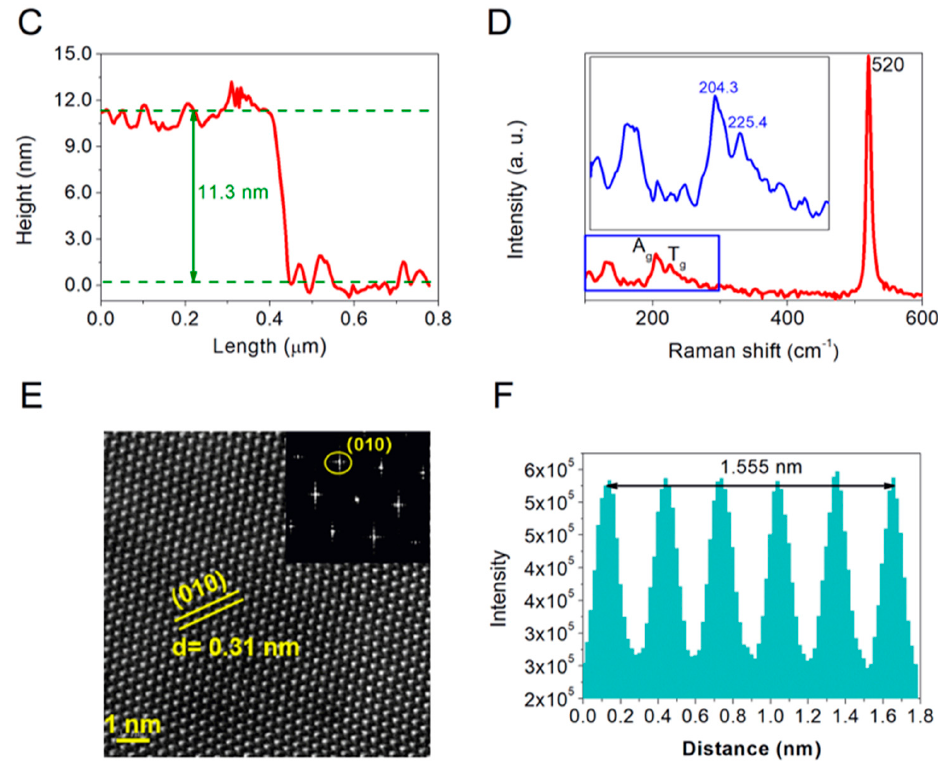
Figure 3. The characterization of as-grown NiSe flakes. ( A ) High-resolution XPS spectrum of grown NiSe in Ni 2p regions. ( B ) High-resolution XPS spectrum of grown NiSe in Se 3d regions. ( C ) Height profile of as-grown NiSe characterized by AFM technology. ( D ) Raman spectra of as-grown NiSe samples with a laser excitation wavelength of 532 nm. ( E ) STEM patterns of NiSe flakes on a copper mesh, the scale bar is 1 nm. The lattice distance along the crystal plane (010) is 0.31 nm. The top right inset of the image shows the corresponding selected area electron diffraction pattern (SAED), which demonstrates the hexagon structure of grown NiSe flakes. ( F ) Lattice distance of (010) plane in Figure 3E.